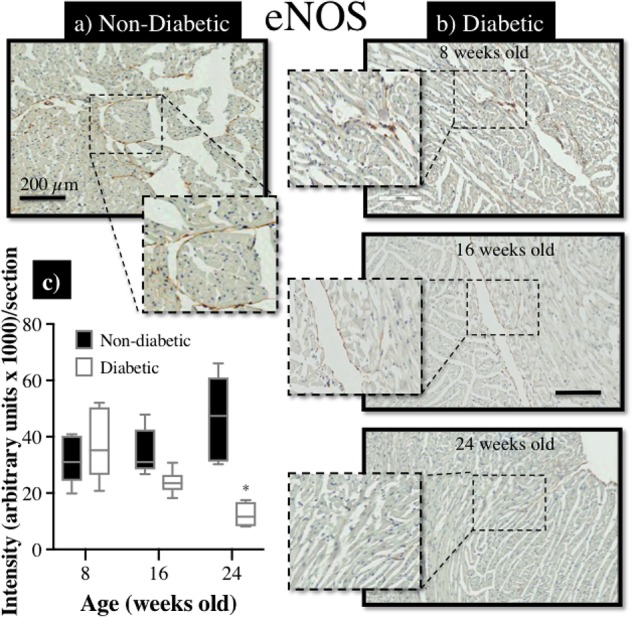
Immunohistochemical assessment of eNOS protein expression in myocardial sections retrieved from db/db (a) non-diabetic mice and, (b) diabetic mice at 8, 16, and 24 weeks of age; (c) the intensity of eNOS staining (brown precipitate) appeared to be progressively reduced with age in diabetic hearts, compared to non-diabetic hearts, and significantly more so by 24 weeks of age (∗P < 0.05).